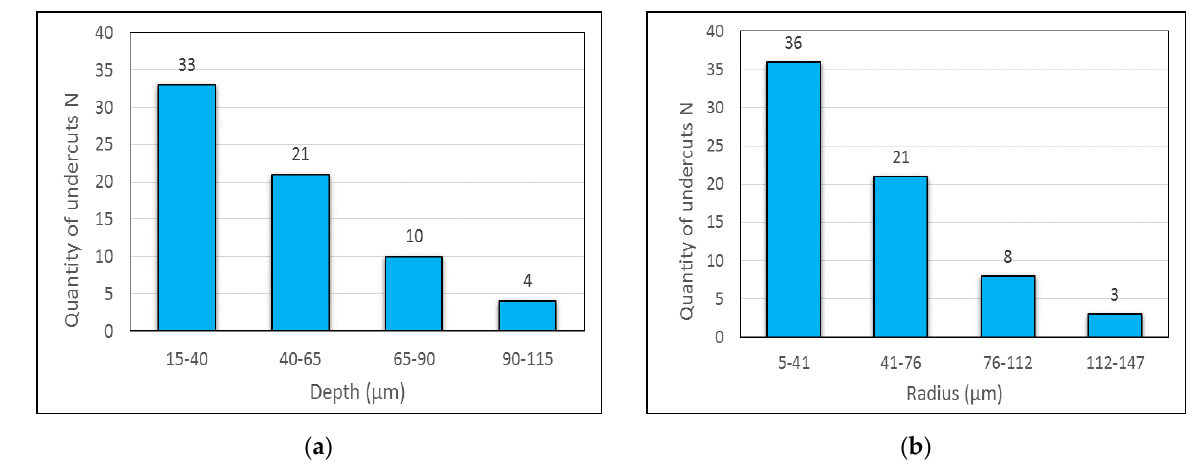
Figure 6. Distributions of undercut parameters for the set of series: ( a ) depth; ( b ) radius.